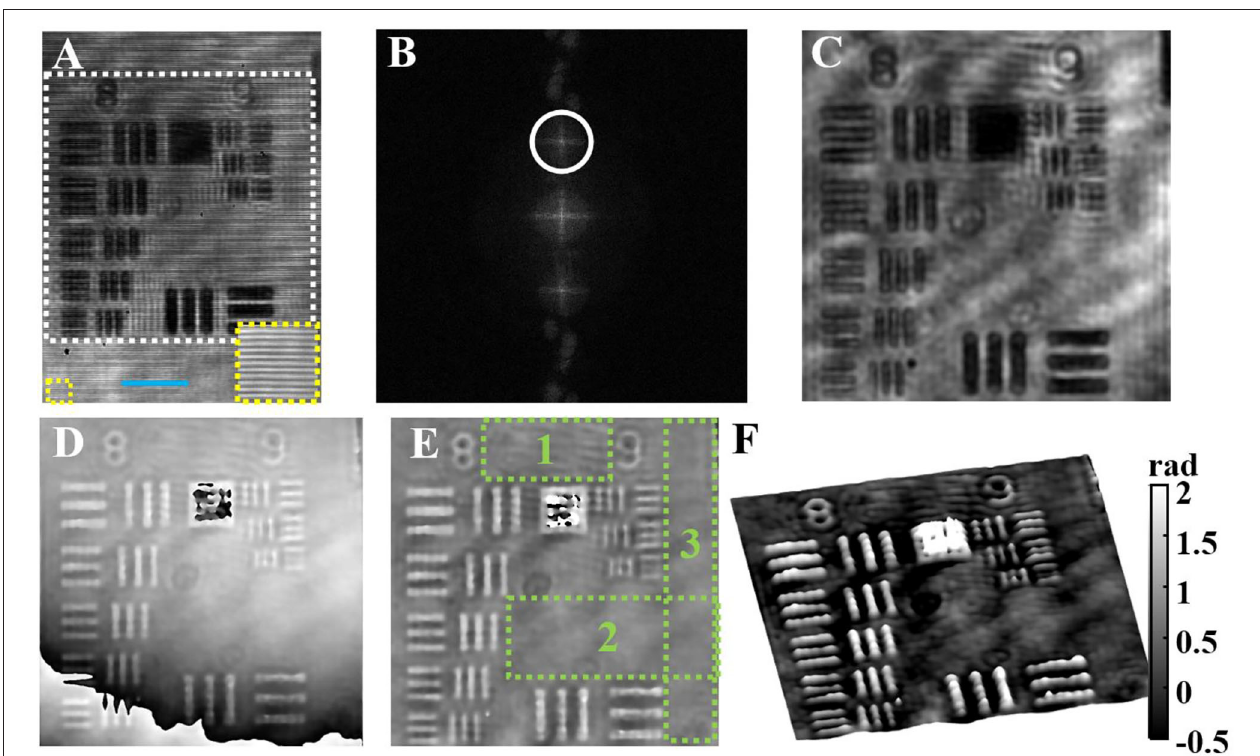
FIGURE 2 | Experimental validation of SER-DHM involving a negative USAF test target. (A) Off-axis digital hologram. (B) Fourier transform of (A) including the filter applied for Fourier filtering. (C) Retrieved amplitude distribution. (D) Retrieved phase distribution. (E) Phase map after spherical wavefront compensation. (F) 3D phase visualization. Blue scale bar in (A) means 20 µ